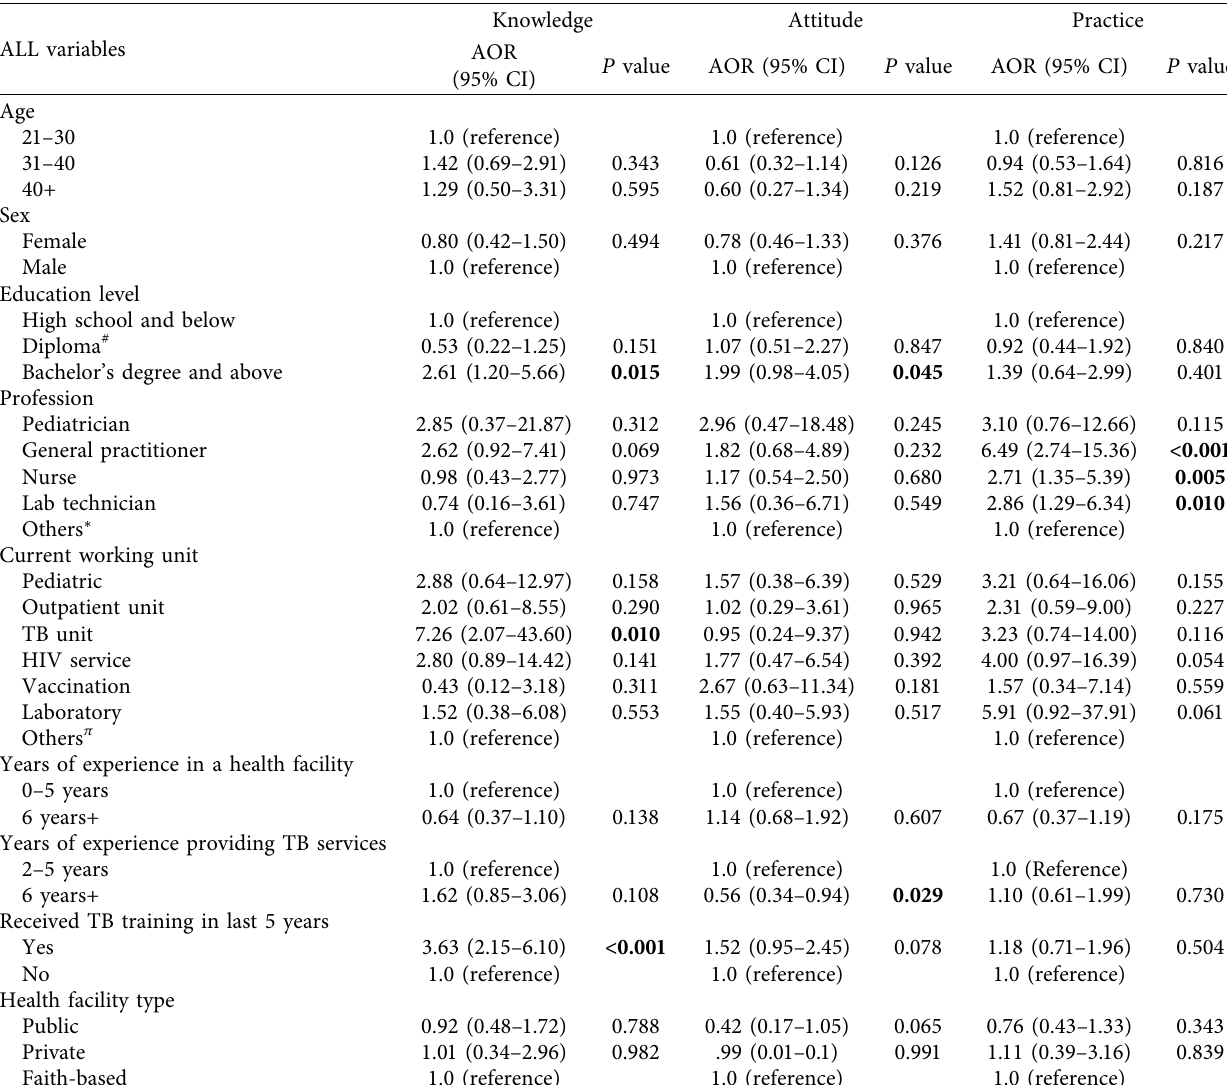
Table 5: Association between the demographic characteristics and knowledge, attitude, and practice in pediatric TB